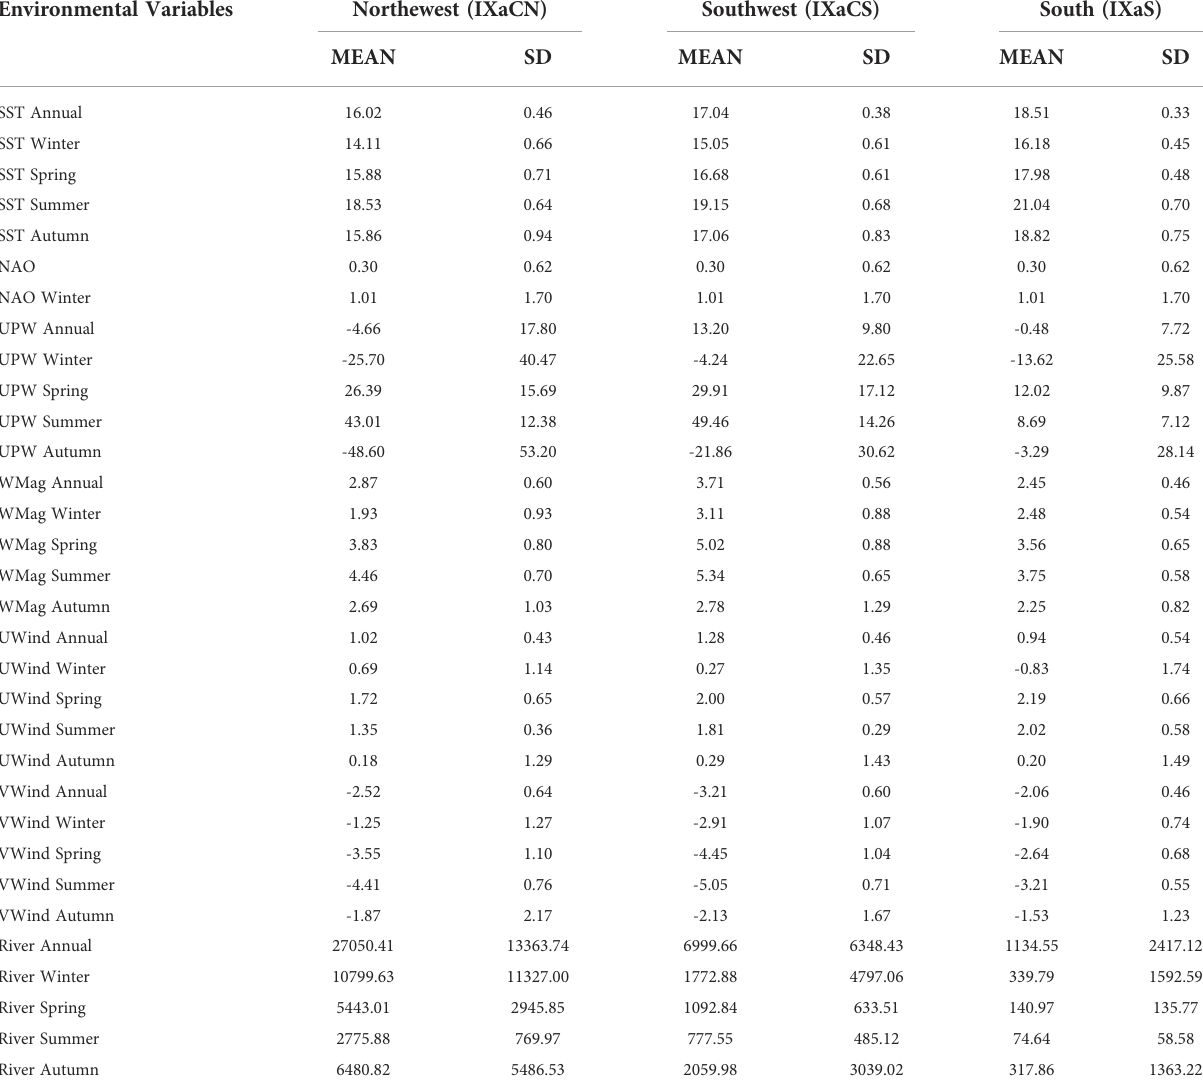
TABLE 2 Yearly and seasonal means and standard deviations (SD) for oceanographic, hydrological and climatic variables used in the time series analysis for the period from 1989 to 2009 along the Portuguese coast: Northwest (IXaCN), Southwest (IXaCS) and South (IXaS). Environmental